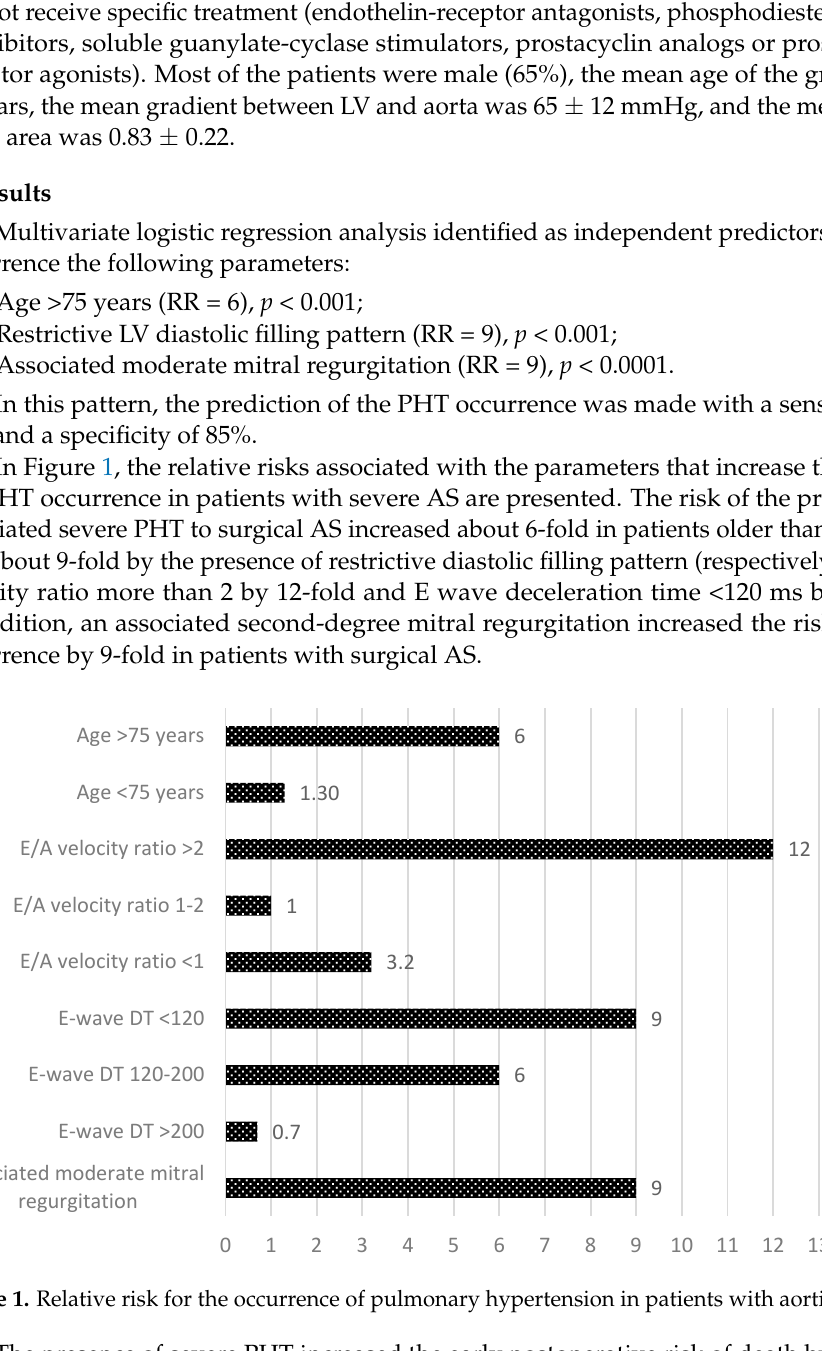
Figure 2. Relative risk for cardiovascular complications and early postoperative death depending on the presence of pulmonary hypertension. Regression analysis identified as independent predictors for early postoperative mortality the presence in those patients of the following parameters (Figure 3):